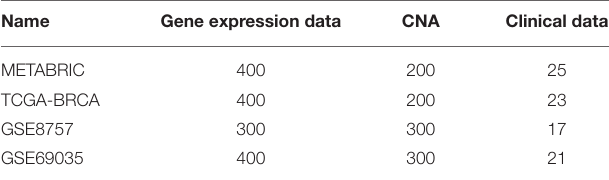
TABLE 2 | The number of feature after feature